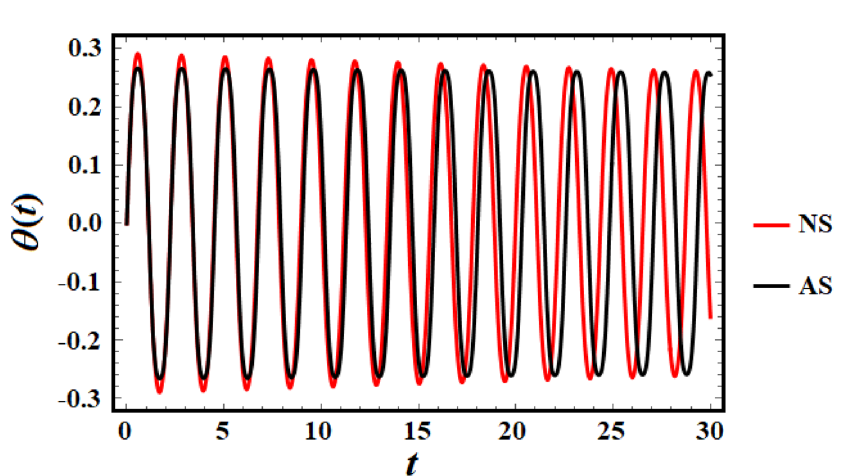
Figure 3. Portrays the corresponding curves of part of Fig. 2 in the plane θ L = 0.7, σ( = 4.01, 6.94 ) , and ( c ) L = 1, σ( = 2.78, 4.82 ) .